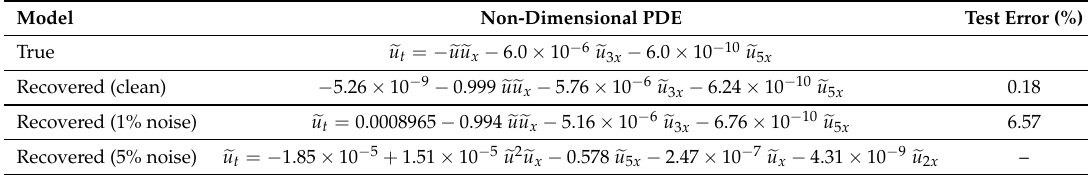
Figure 10. Non-dimensional analytical solution of Kawahara equation. Table 8. Identifying Kawahara equation using